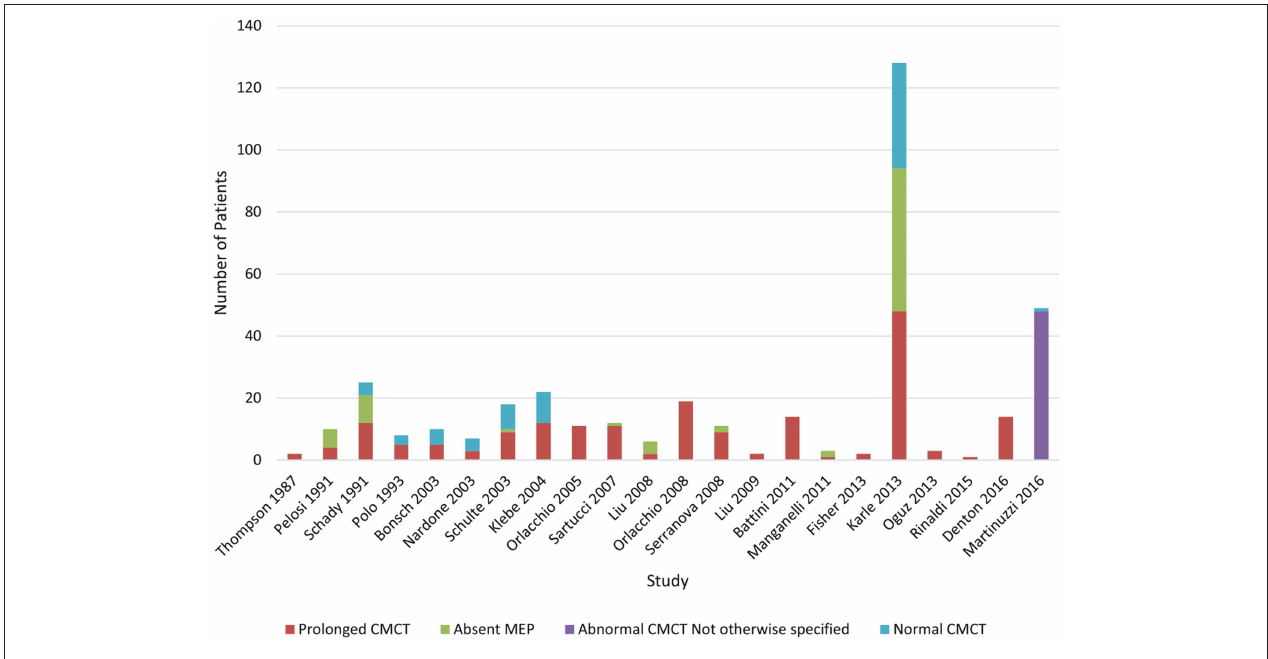
Chart 2 | Studies of lower limb MEPs. Data available in Table 4.3 , Appendix 4.